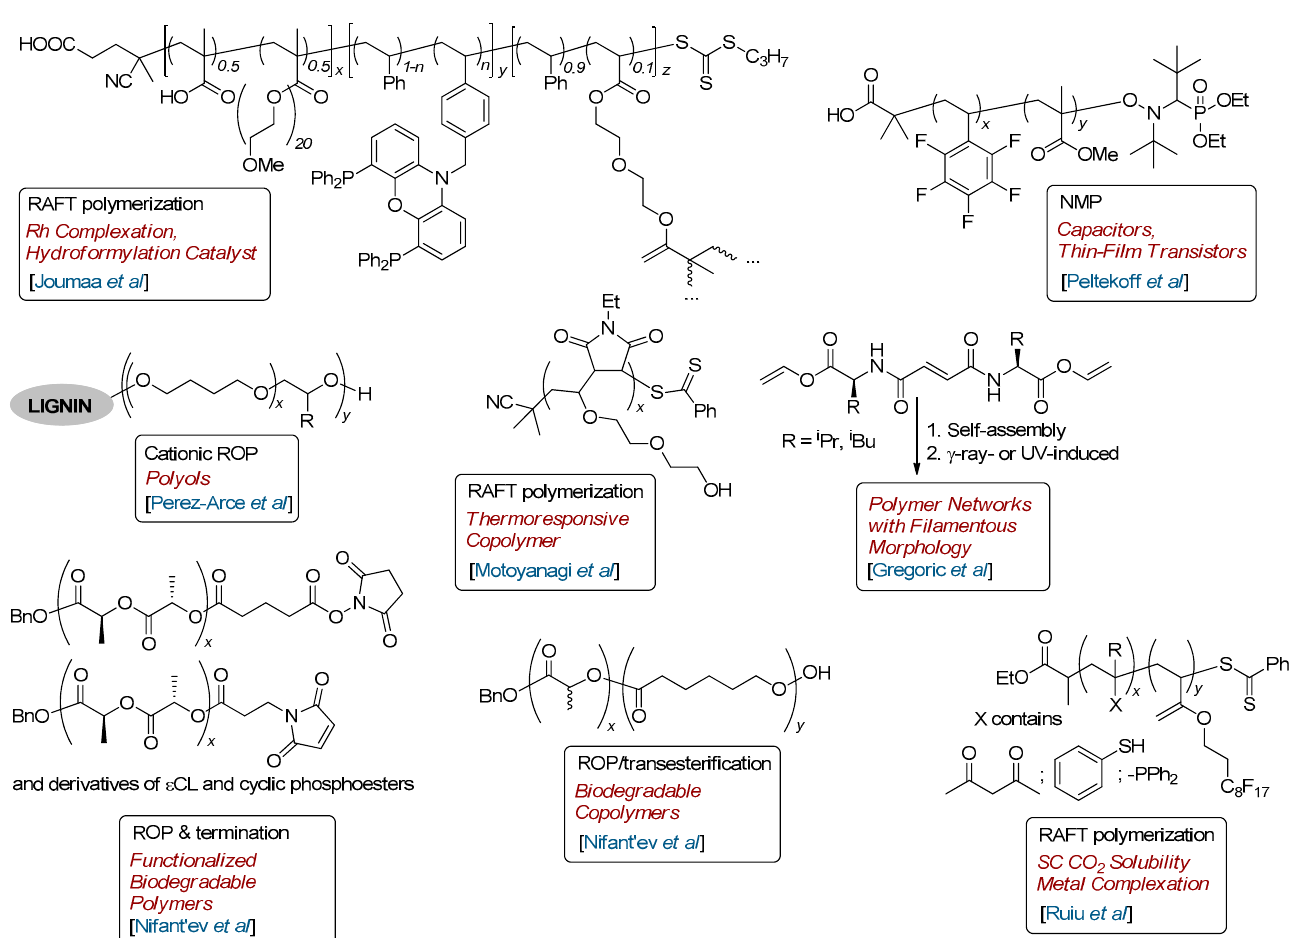
Figure 1. Special Issue entitled ‘Controlled Polymerization’: copolymers synthesized in a targeted and controlled manner and controlled manner.